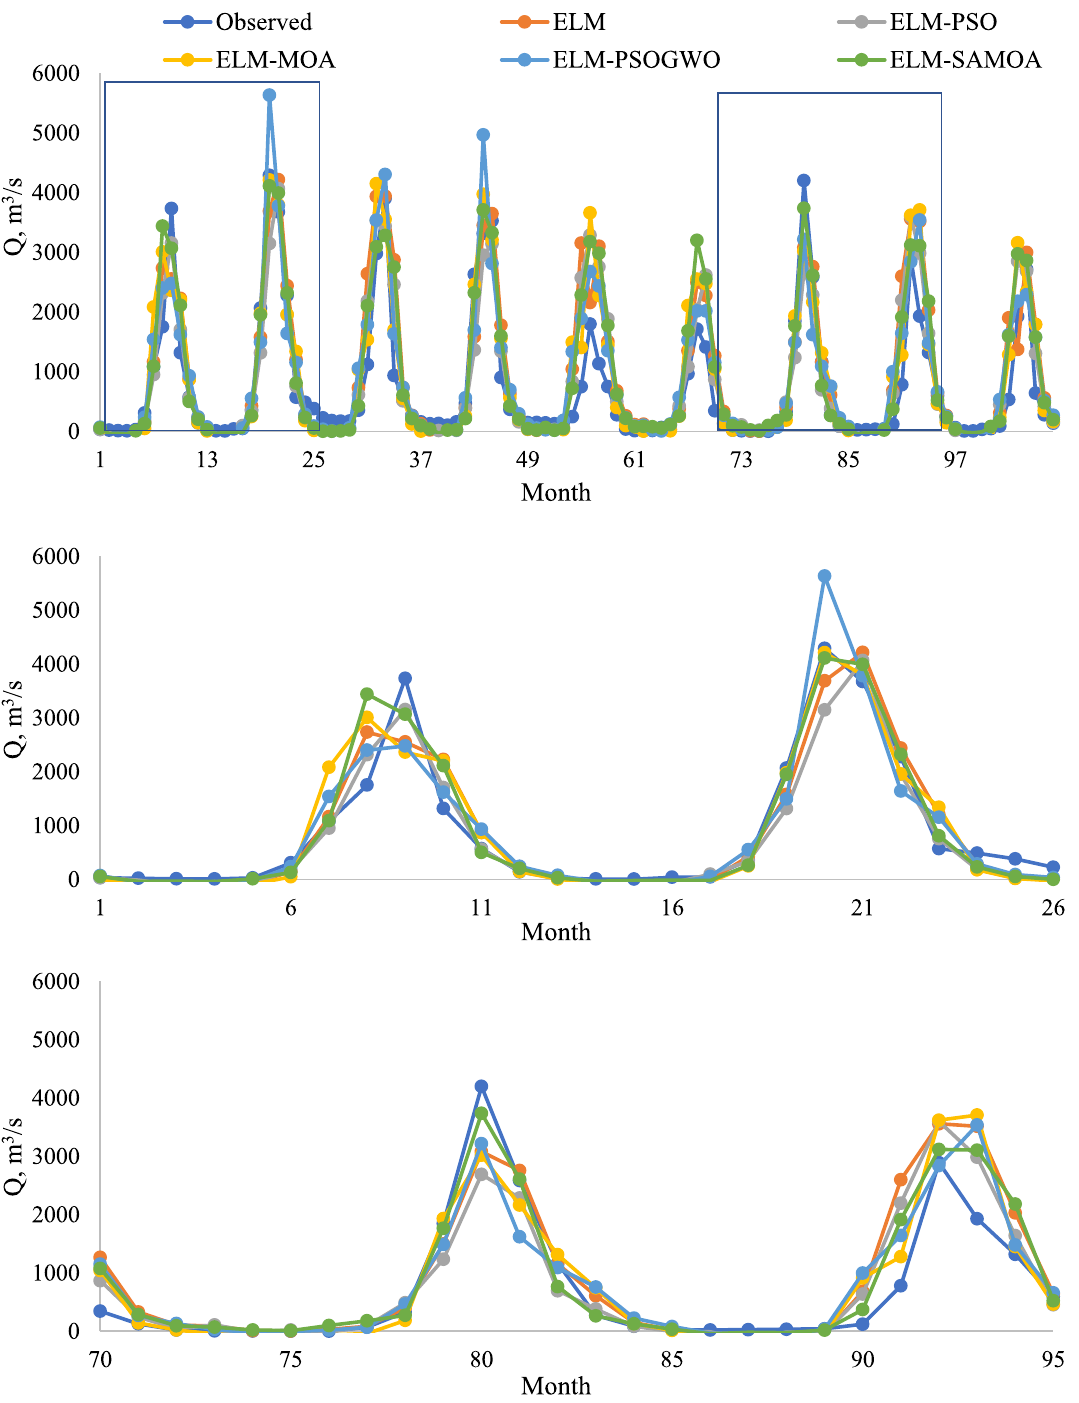
Fig. 11 Time variation graphs of the observed and predicted streamflows by different ELM-based models in the test period of Gorai station (d/s) using Padma station data